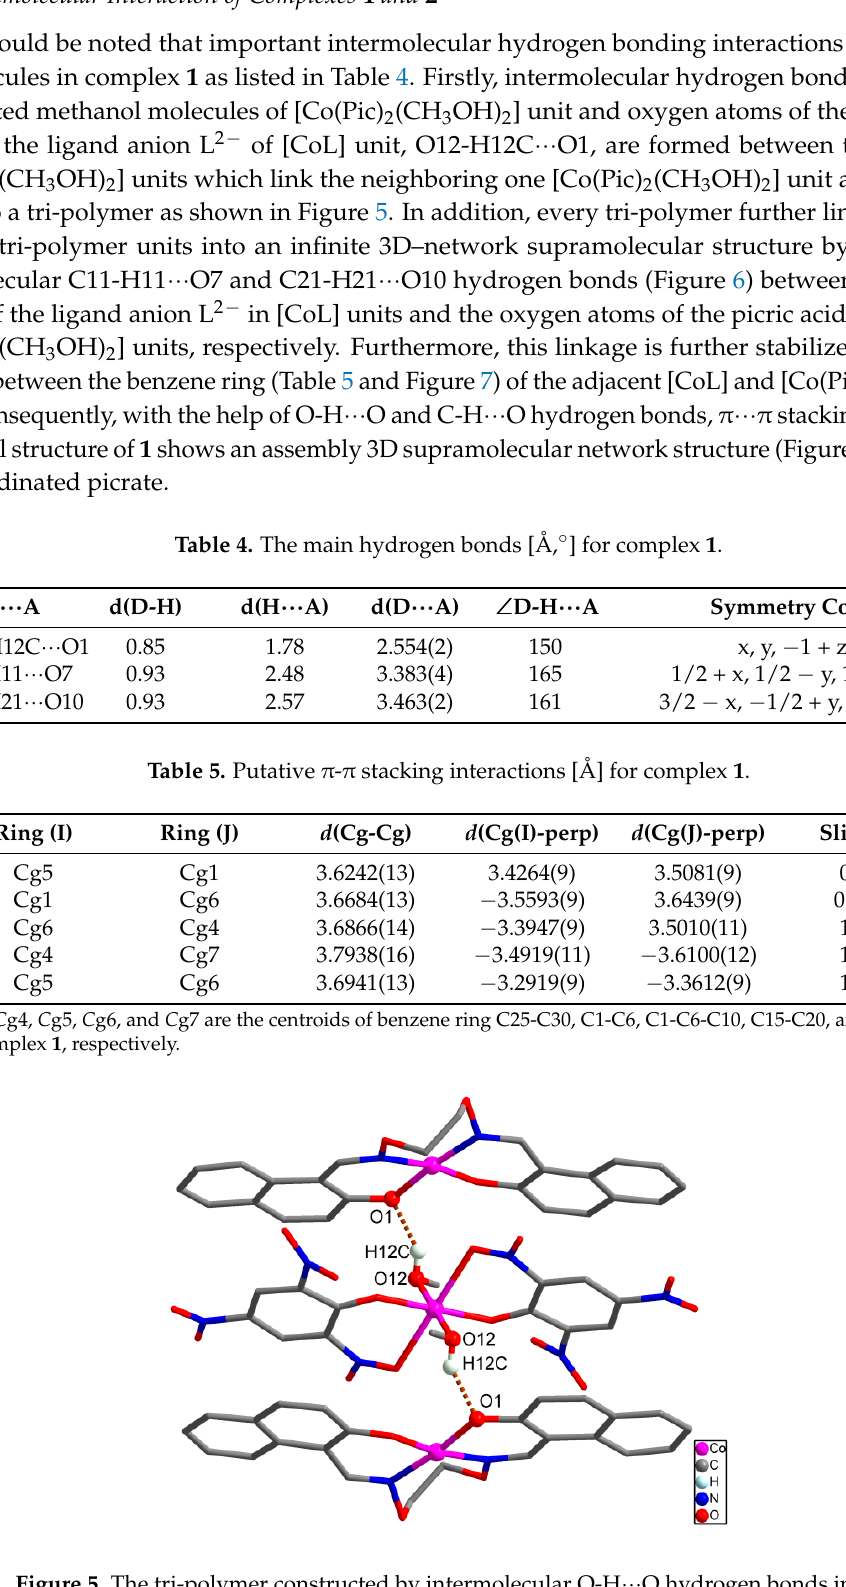
Figure 5. The tri-polymer constructed by intermolecular O-H···O hydrogen bonds in 1 .